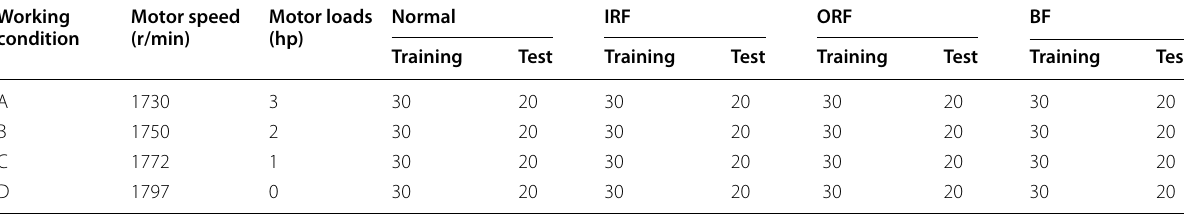
Table 2 Experimental data for bearing fault diagnosis Working